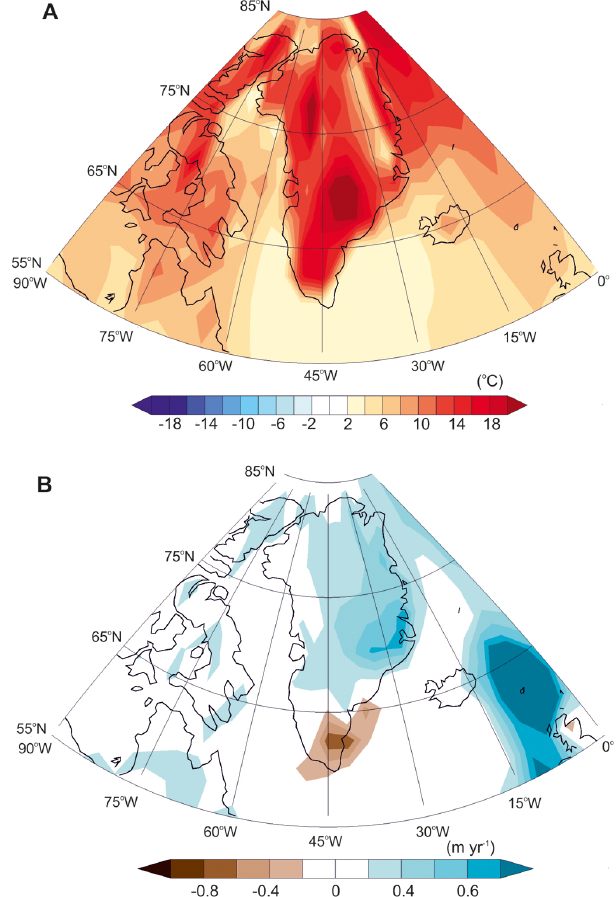
Fig. 4. (a) HadAM3 Pliocene minus pre-industrial mean annual sur- face air temperature ( ◦ C) and (b) mean annual precipitation rate (myr − 1 ) anomaly over Greenland. Pliocene simulations include the PRISM3 ice sheet boundary conditions (Fig. 3b; Hill, 2009; Dowsett et al.,